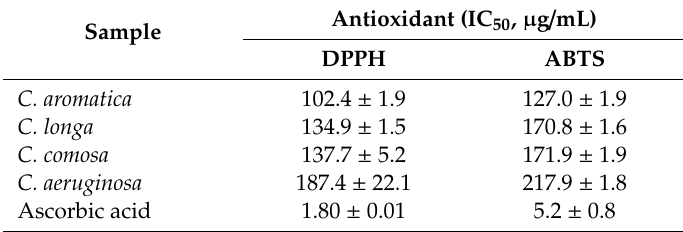
Table 2. Antioxidant activities of EtOH extract from the rhizome of C. aromatica, C. longa, C. comosa, and C. aeruginosa .